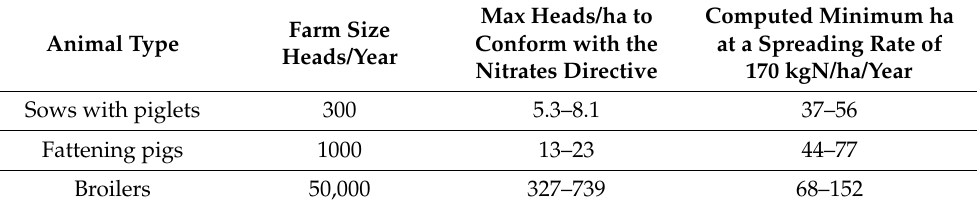
Table 3. Maximum allowable numbers of animals per ha to comply to the Nitrates Directive manure application of 170 kgN/ha/year with their corresponding farm sizes and minimum numbers of ha for manure spreading for large intensive pig and poultry farms. Based, in part, on data in the EU IPPC BATs Reference Document